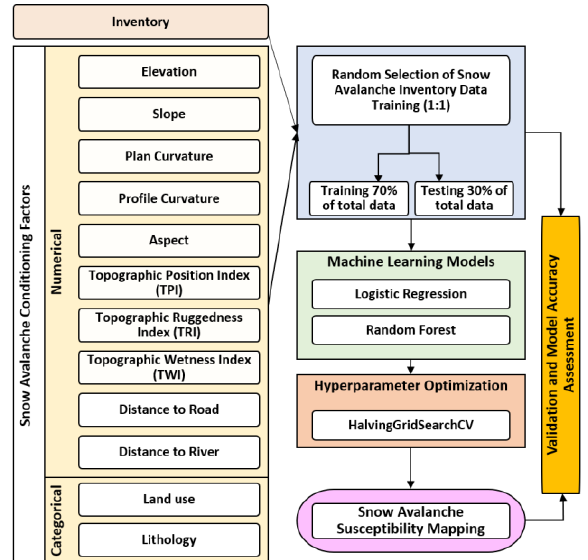
Figure 2. Flowchart of the methodology.